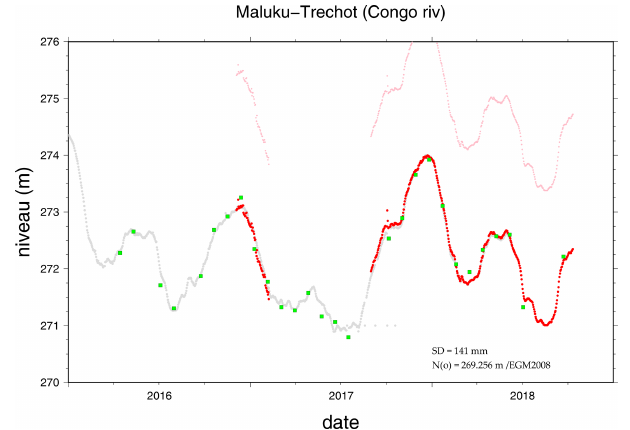
Figure 2. Comparaison entre les hauteurs d’eau estimées par alti- métrie avec l’altimètre Sentinel 3 et les stations de Maluku-Trechot et de Brazzaville situées de part et d’autre de la trace